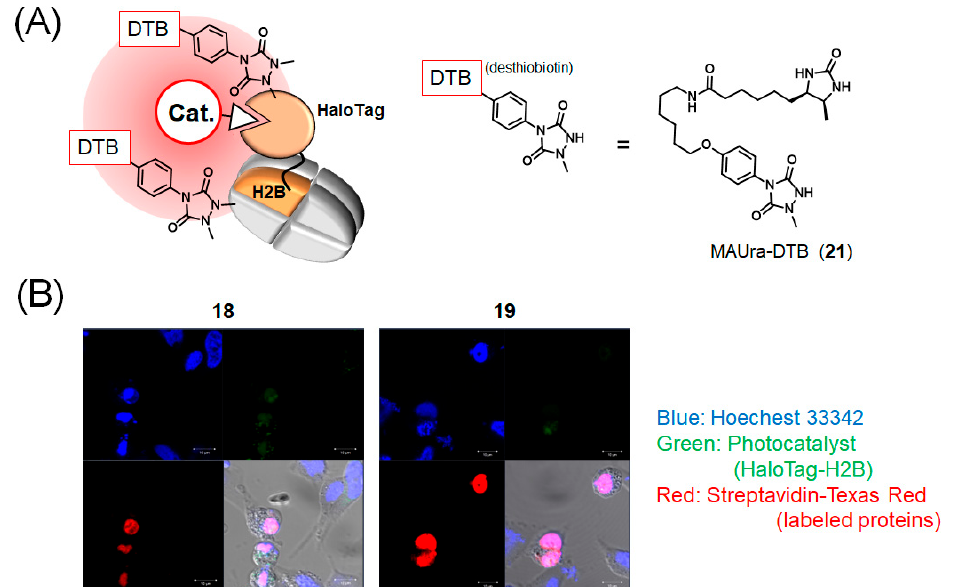
Figure 6. HaloTag-H2B photocatalytic proximity labeling in cells. ( A ) Scheme of the labeling and structure of MAUra-DTB ( 21 ). ( B ) Detection of labeled protein localization and fluorescence of photocatalyst on HaloTag-H2B. Top left: Hoechest 33342. Top left: Photocatalyst. Bottom right: streptavidin-Texas red. Bottom right: Overlay of bright-field image and three-color fluorescent image.